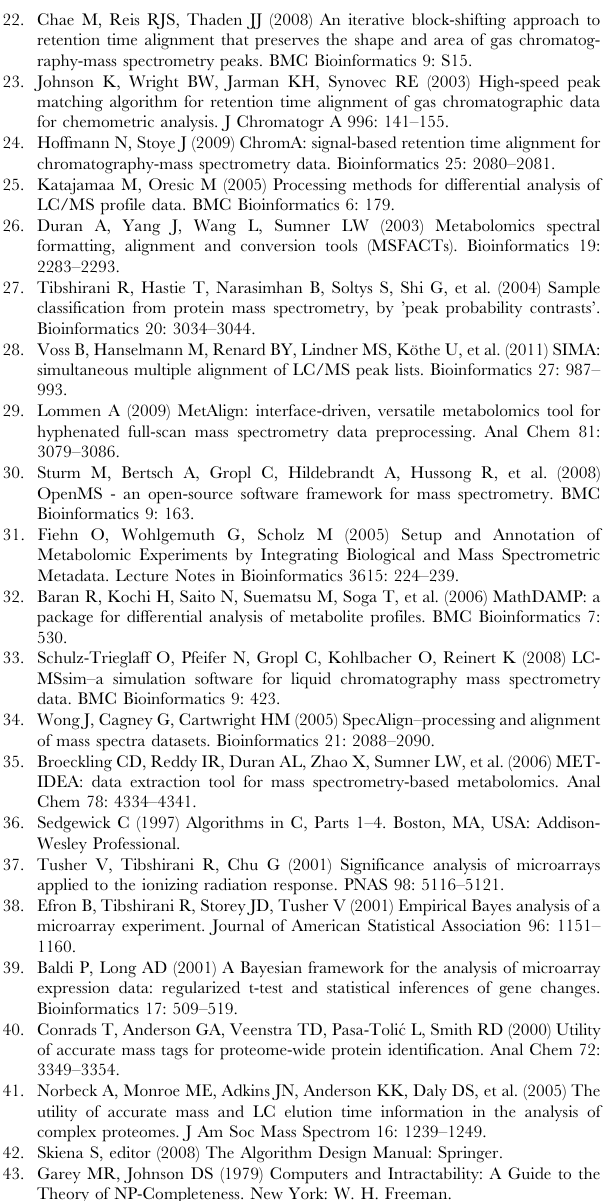
PAD. Dashed lines represent CAM curves of PASS and dotted lines represent CAM curves of SIMA (mass resolution 0.00001 Daltons). Figure S3 p value distributions of three modified t tests. Both horizontal and vertical axes represent p values ranging from zero to one. Figure S4 Instructions for using